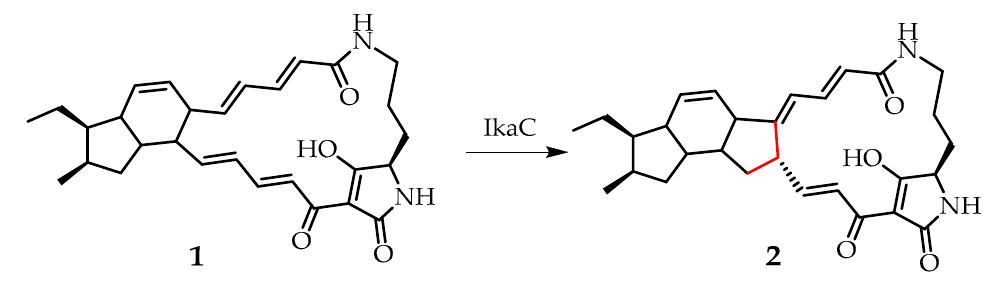
Figure 1. Formation of ikarugamycin ( 2 ).